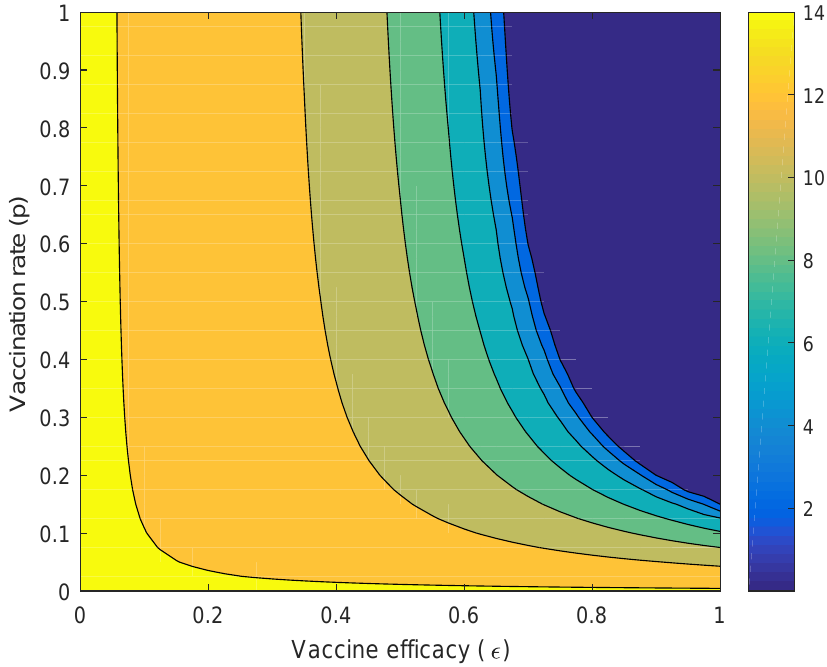
Figure 5. Countour plot of vaccine efficacy ( (cid:101) ) and the vaccination rate ( p ) against the performance index ( Idx VW